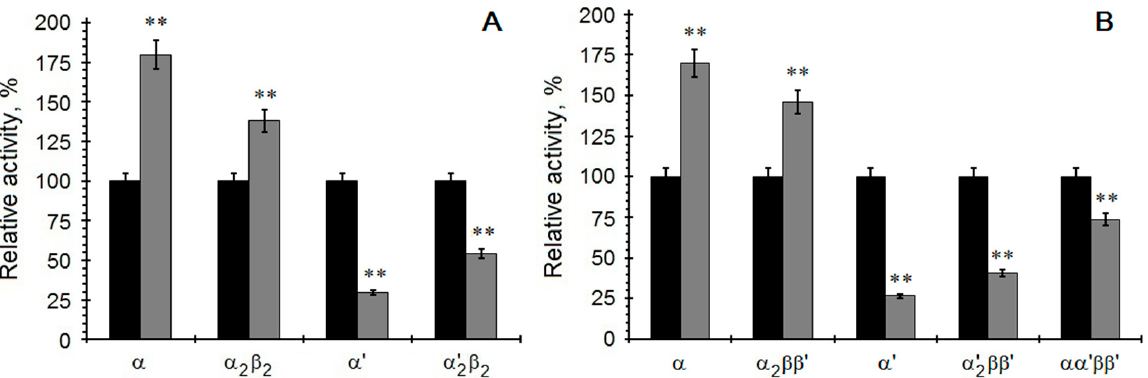
Figure 3. Kinase activity of different CK2 isoforms from human ( A ) and yeast ( B ) in the presence of Asf1. Comparison of activity in the absence (black bars) and in the presence of 1 µM Asf1 protein (grey bars) after preincubation. Relative activity is calculated towards enzyme activity in the absence of Asf1. ** indicates significant difference compared to the controls ( p < 0.01).